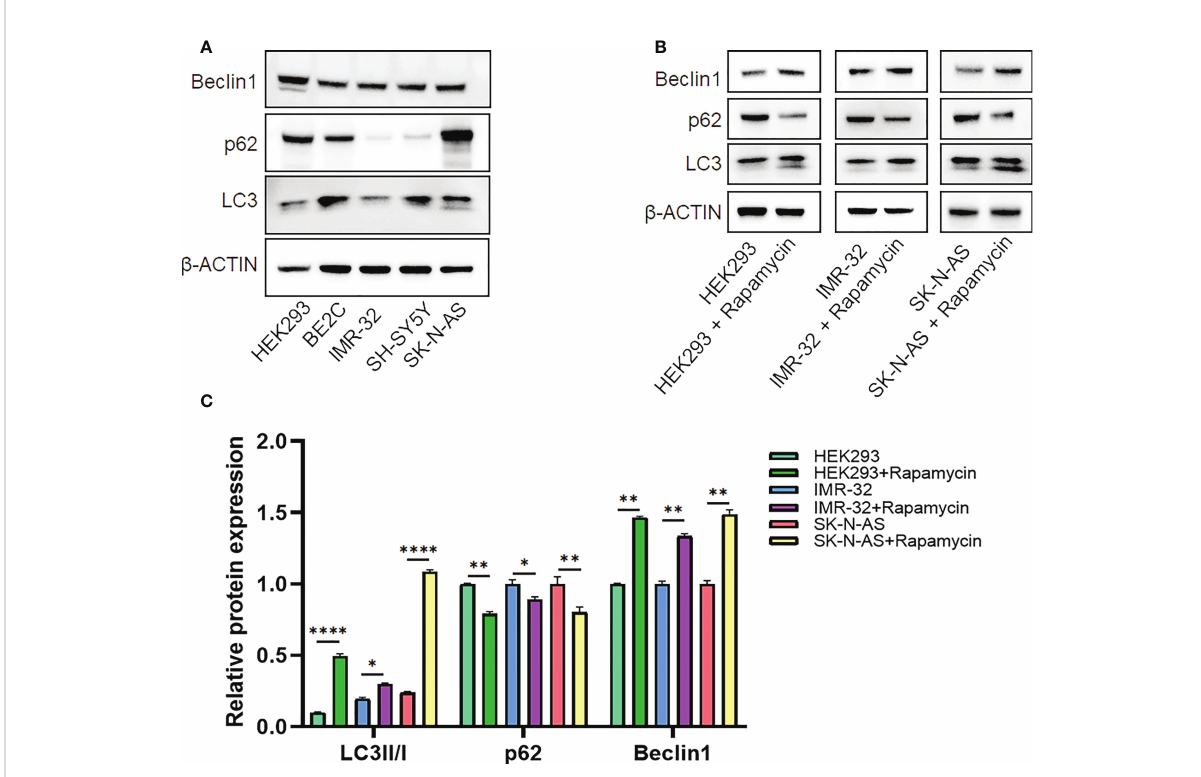
FIGURE 10 The expression of autophagy-related proteins. (A) Wild type cell lines. (B, C) Autophagy-activated cell lines. Results are representative of three independent experiments, * p < 0.05; ** p < 0.01; **** p <